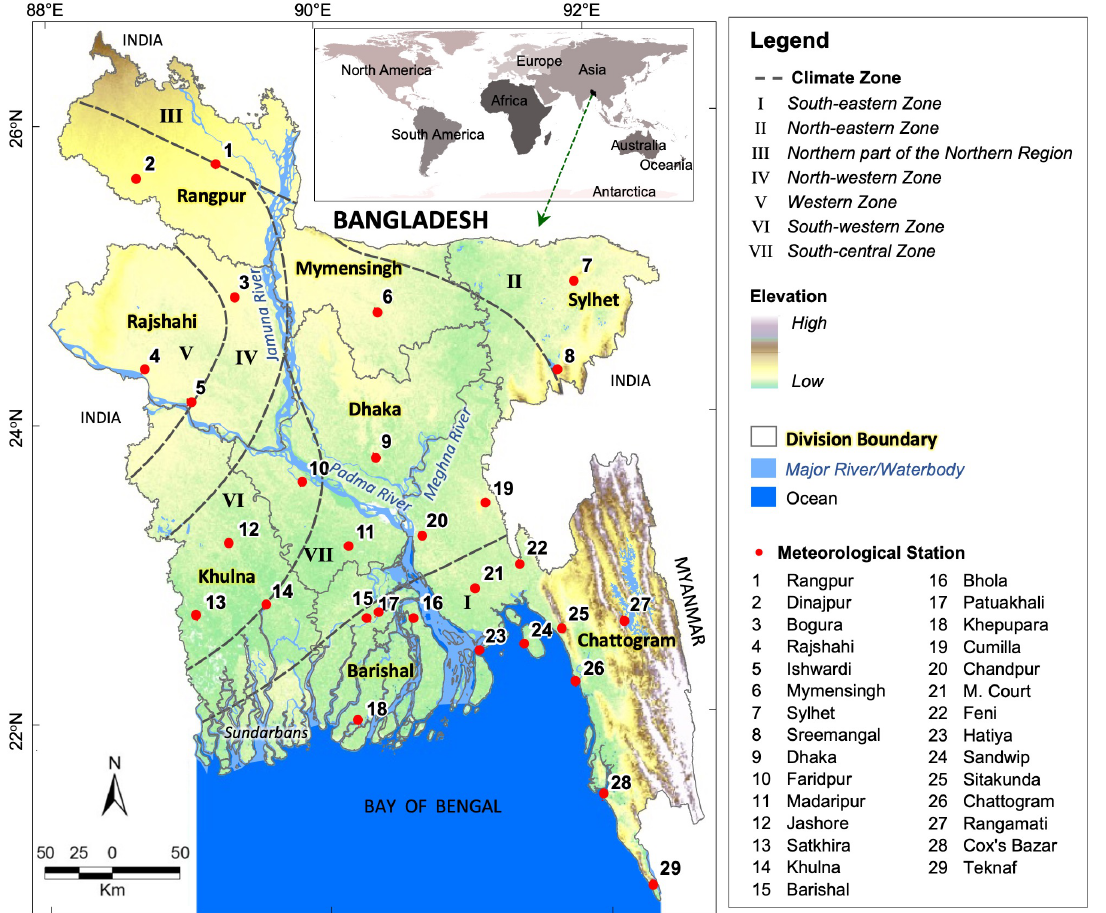
Figure 1. Demonstration of the study area with seven distinct climatic zones and eight administrative divisions (adopted from Alam et al. [1]).